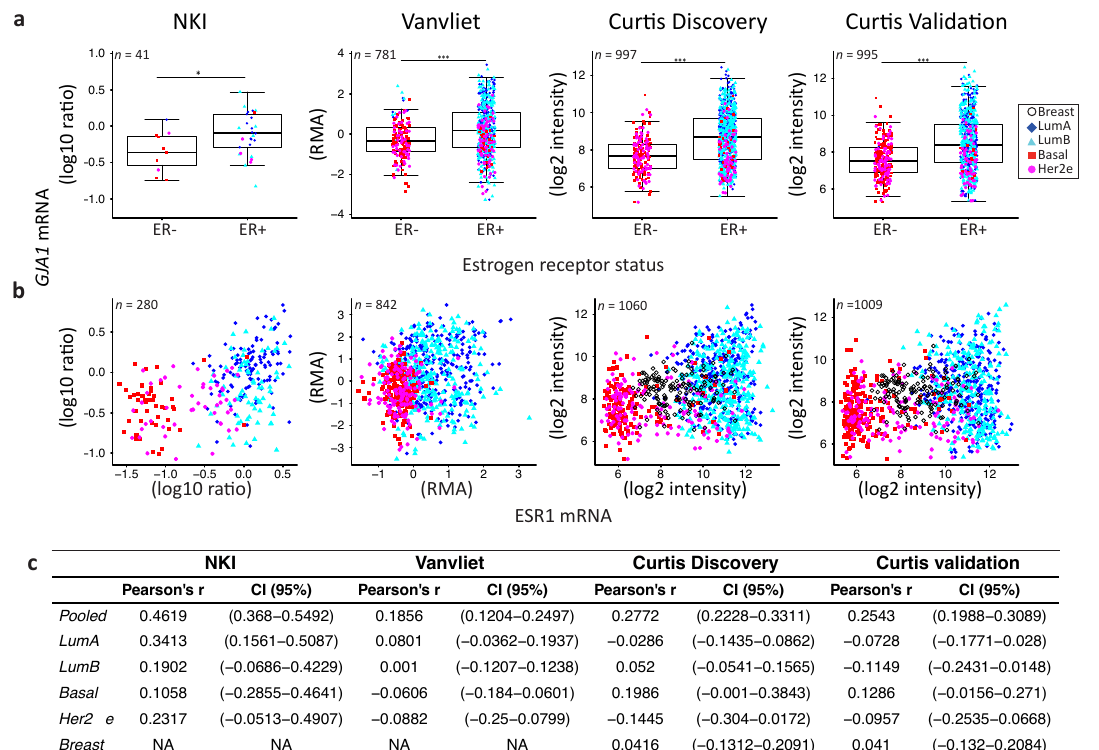
Figure A2. GJA1 mRNA level in breast cancer clinical samples is higher in ER-positive tumors in four datasets. ( a ) GJA1 mRNA level in breast tumors stratified by estrogen receptor status determined as described in Material and Methods. p value: * <0.05; ** <0.01; *** <0.001. ( b ) Expression of GJA1 vs. estrogen receptor alpha ( ESR1 ) mRNA in each subtype and in normal breast tissue. ( c ) Bootstrapped correlations between ESR1 and GJA1 mRNA level either in pooled breast cancer tumors or in individual intrinsic subtypes and in normal breast tissue. Data from Vanvliet, NKI, Curtis Discovery and Curtis Validation